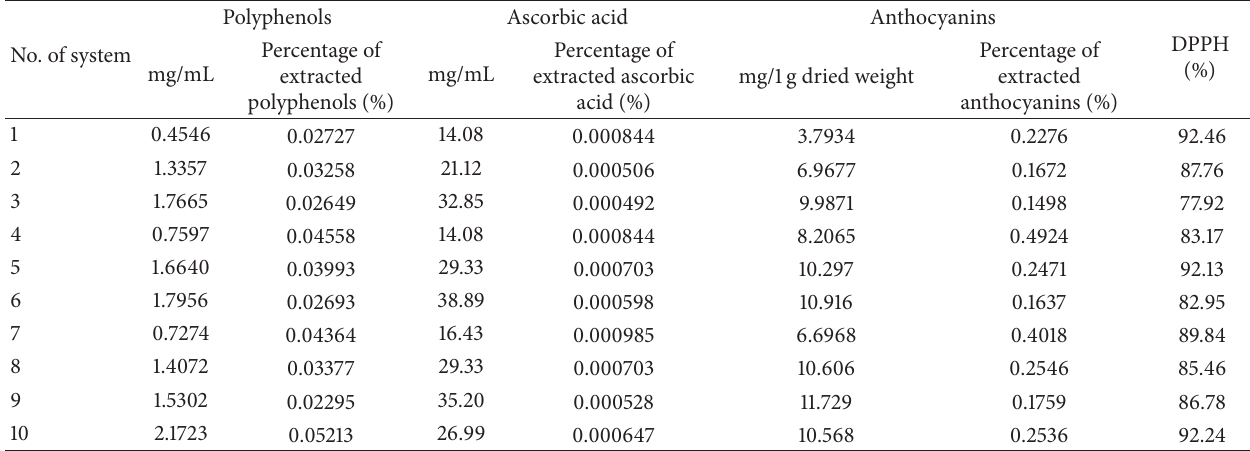
Table 2: Results of the quantitative analysis and effectiveness of antioxidant in dog rose